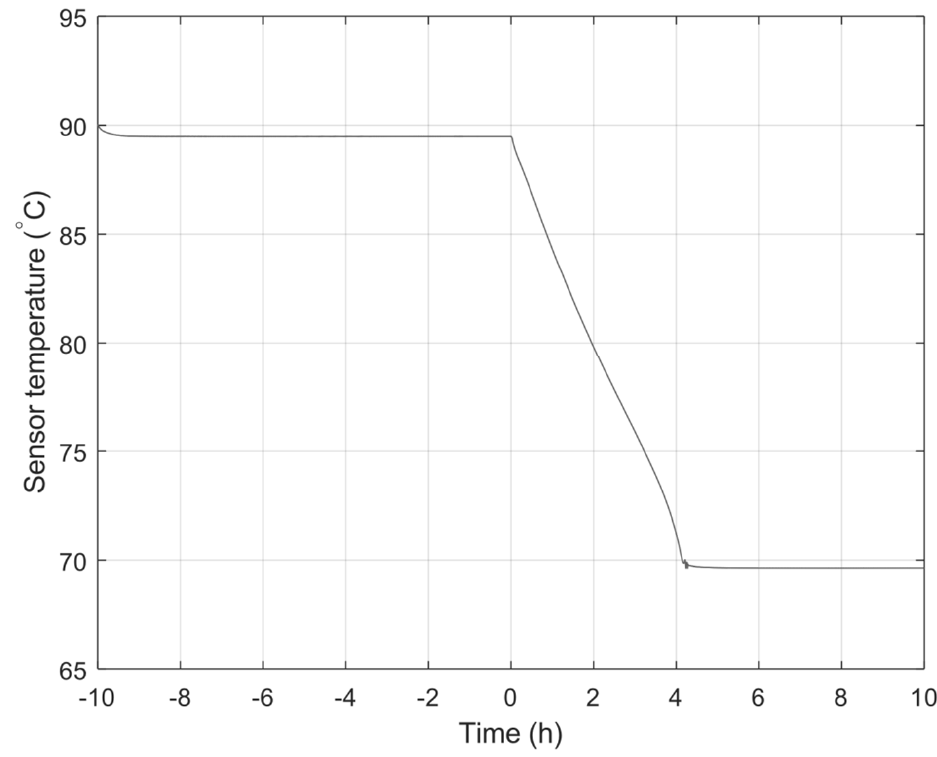
Figure 7. Temperature sensor response after a step change in supply temperature at time zero. The initial temperature in the drainage valve pipe is 90 °C at t = − 10 h; at time zero, the supply temperature drops to 70 °C.